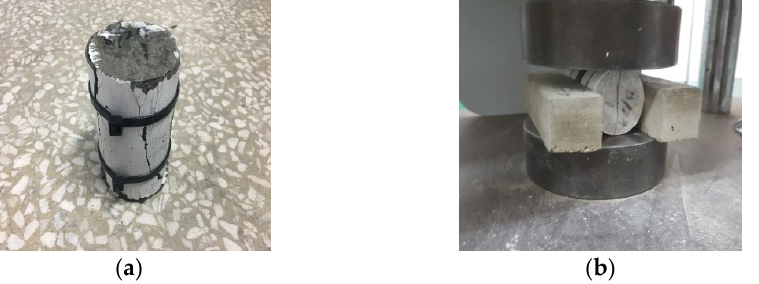
Figure 5. Splitting tensile strength re-load test: ( a ) fracture specimen for re-load test, ( b ) re-load test of fractured specimens after the healing period.